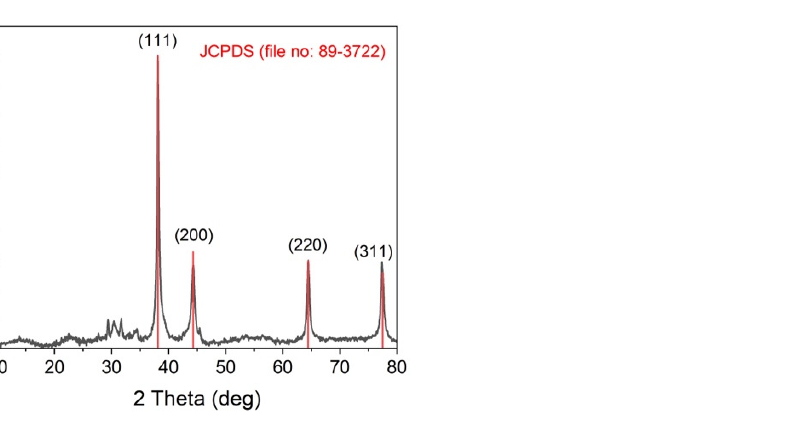
Figure 2. XRD spectra of AgNPs synthesized by the mycelia-free aqueous extract of S. hirsutum .